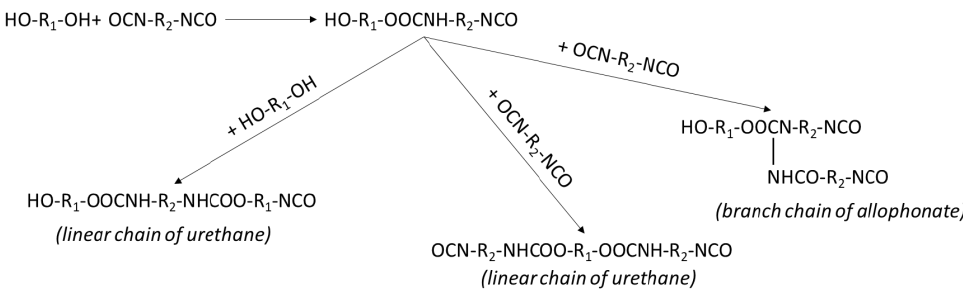
Figure 1. The copolymerization mechanism of diol (HTPB) and diisocyanate (TDI). The kinetics model based on the hydroxyl groups from HTPB (A) reacting with isocyanate groups from TDI (B) produced urethane groups (D) via linear bonding. The urethane groups (D) then reacted with other isocyanate groups (B) to produce allophanate groups (E) via branch bonding. The reactions were expressed in Equations (1) and (2). The isocyanate groups (B) also reacted with a nitro group (F) in hexogen to produce diazene oxide groups (G) and carbon dioxide (H) [29]. The reaction was expressed in Equation (3). In the coating of hexogen, there were competitive reactions involving the isocyanate with hydroxyl groups of HTPB, urethane groups of polyurethane, and nitro groups of the hexogen.